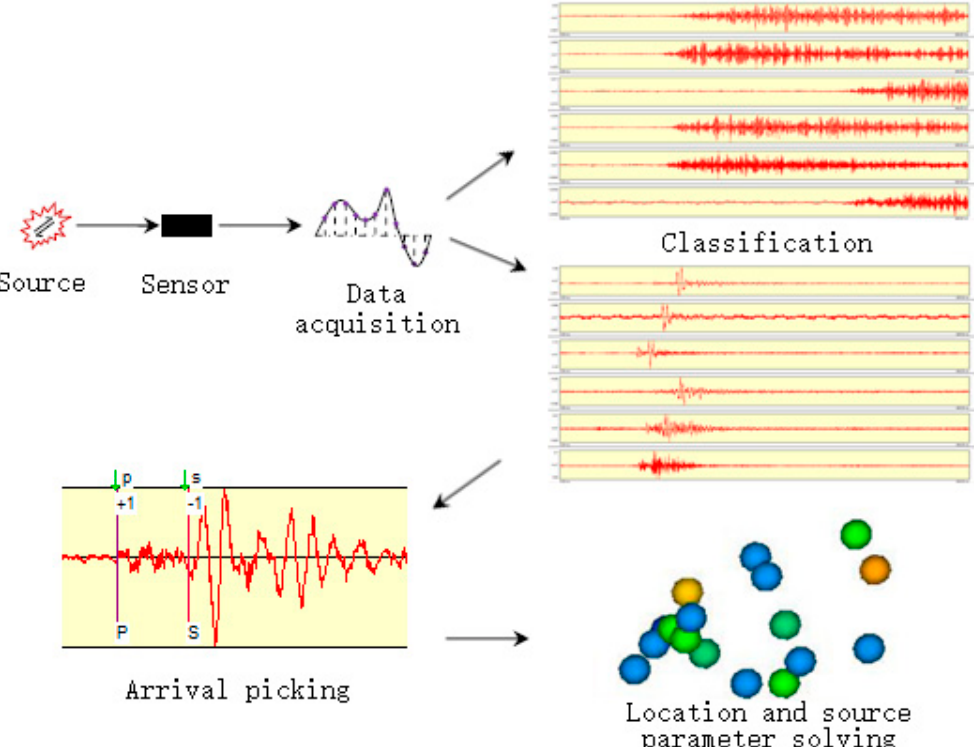
Figure 1. Microseismic signal acquisition and data processing.